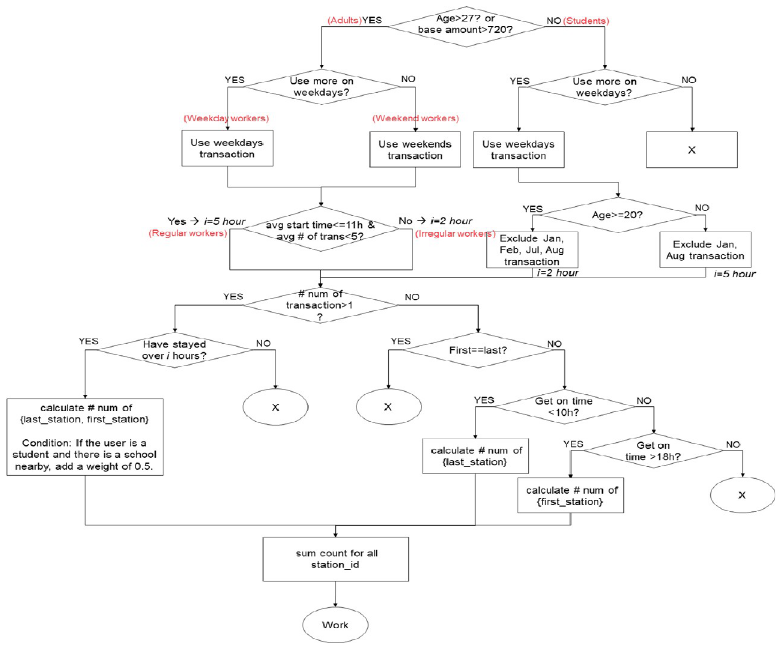
Fig 5. Rules for extracting the “workplace”